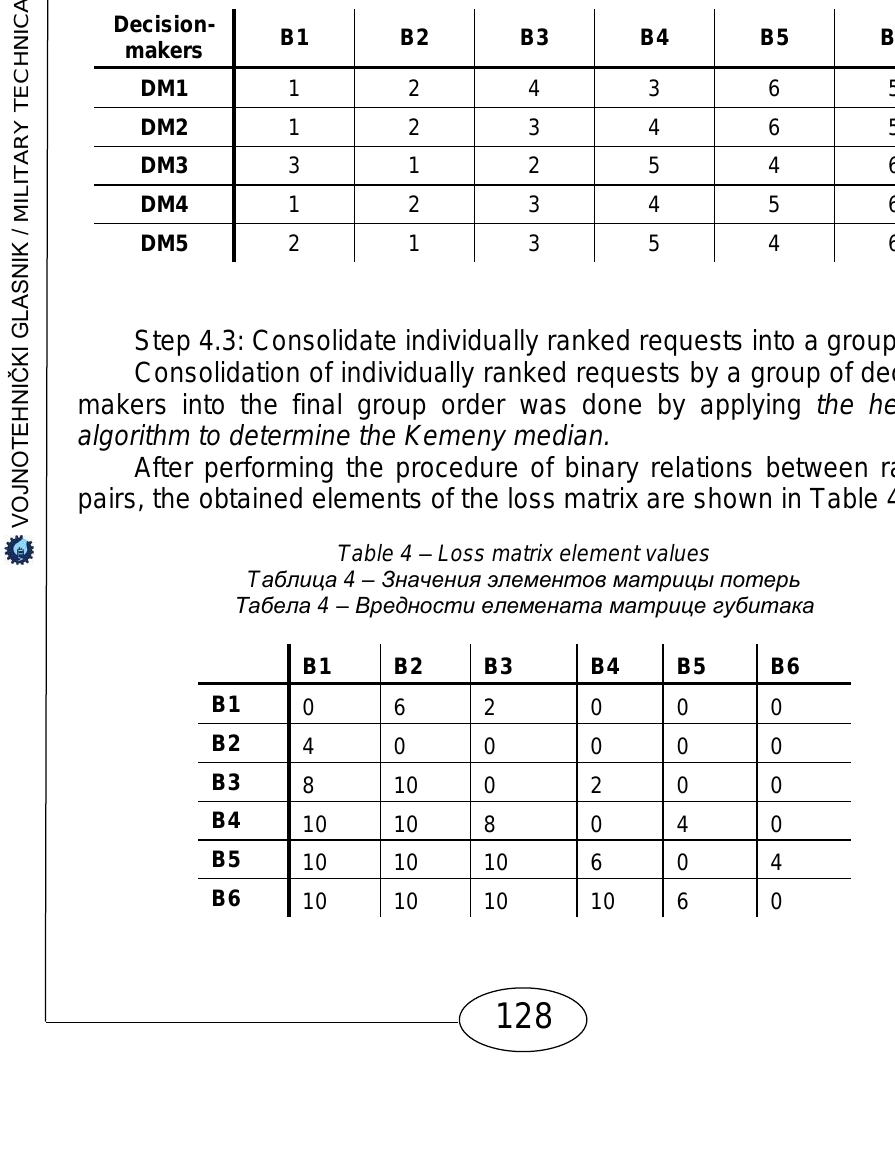
Table 3 – Overview of the ranked user requests by the decision